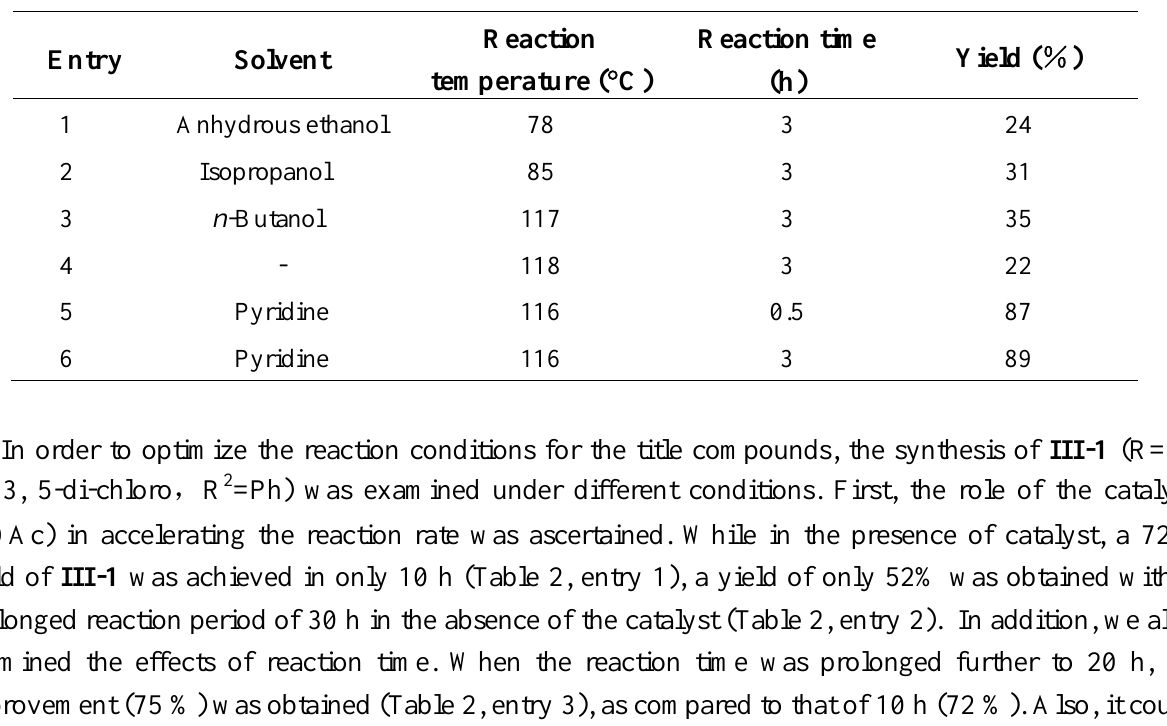
Table 1. The effect of reaction conditions on yield of intermediate II-1 (R=H, R 1 =H, R 2 =Ph).